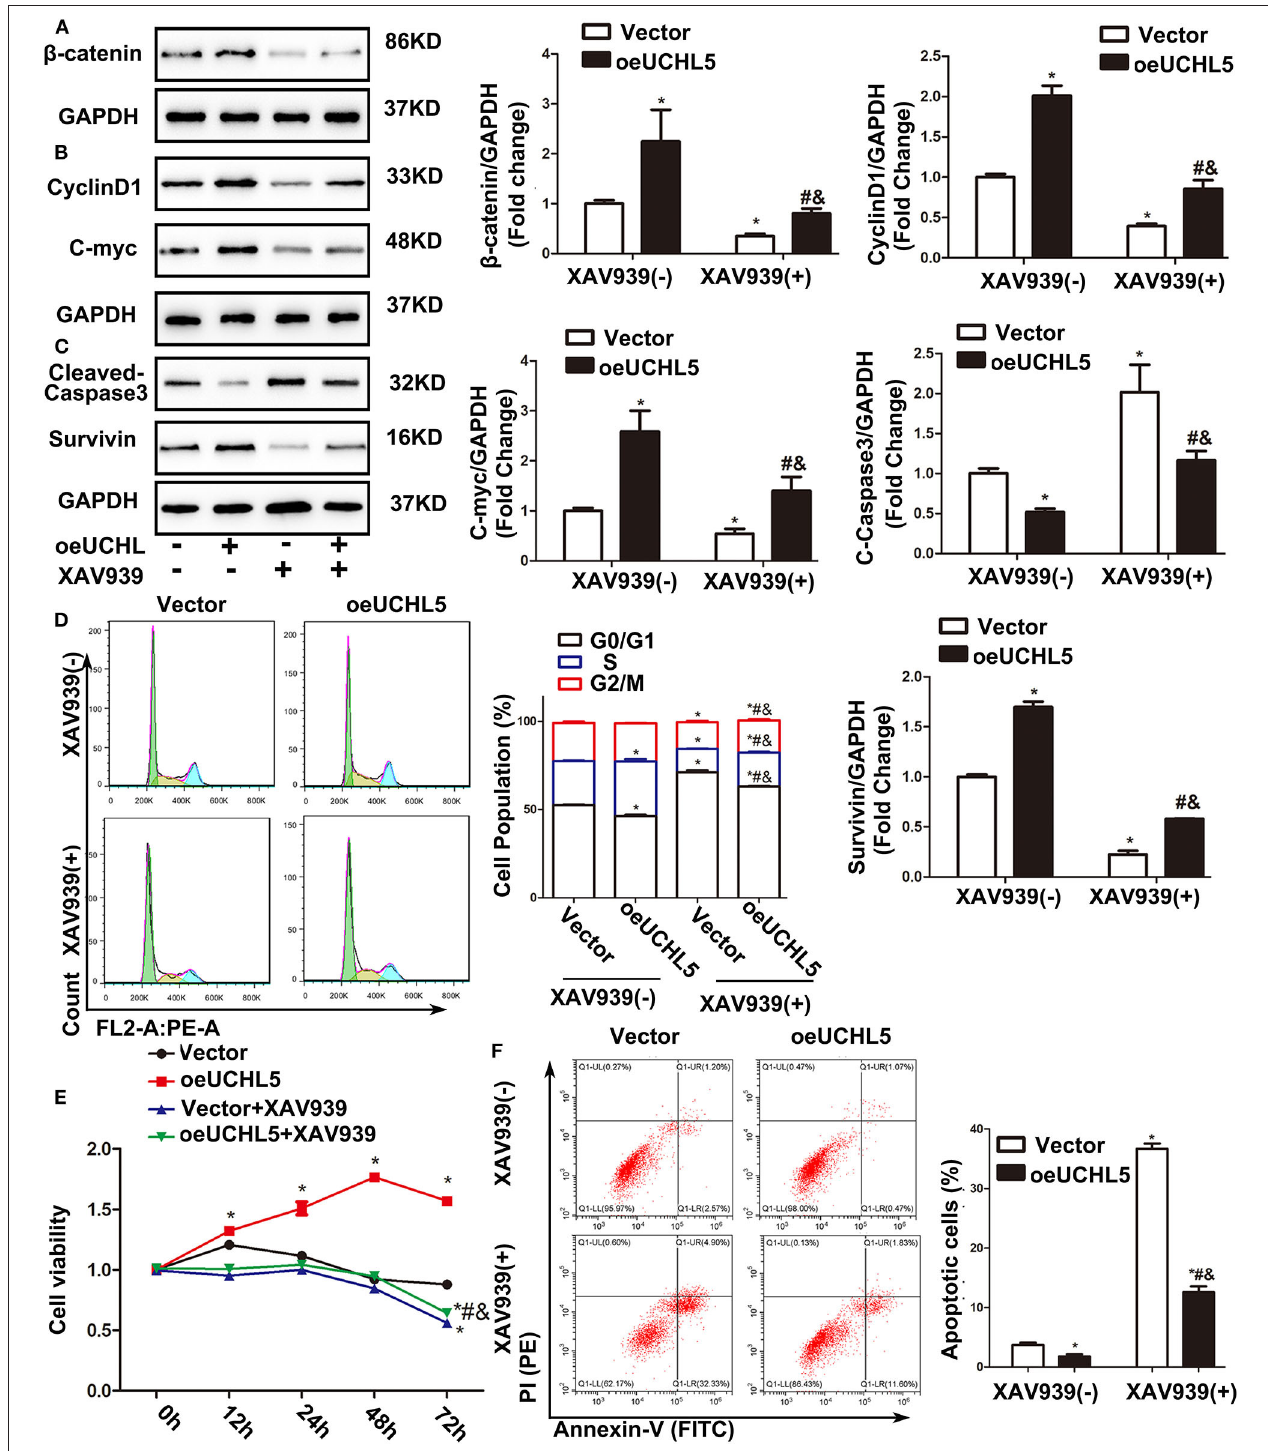
FIGURE 6 | Wnt/ β -catenin signaling pathway inhibitor XAV939 eliminated the disadvantages aroused by UCHL5 overexpression in AN3-CA cells. (A) UCHL5 overexpression (oeUCHL5). AN3-CA cells were treated with or without Wnt/ β -catenin signaling pathway inhibitor XAV939 (10 µ M) for 24h. Relative protein levels of β -catenin were detected by WB. * P < 0.05 vs. empty vector; # P < 0.05 vs. oeUCHL5; & P < 0.05 vs. vector + XAV939. (B,C) Relative protein levels of CyclinD1, C-myc, cleaved-caspase3, and Survivin were detected by WB. * P < 0.05 vs. empty vector; # P < 0.05 vs. oeUCHL5; & P < 0.05 vs. vector + XAV939. (D) Cell cycle was measured by Cell Cycle Analysis Kit ( N ≥ 3). * P < 0.05 vs. empty vector; # P < 0.05 vs. oeUCHL5; & P < 0.05 vs. vector + XAV939. (E) Relative cell viability were detected by CCK-8 at different time points ( N = 3). * P < 0.05 vs. empty vector; # P < 0.05 vs. oeUCHL5; & P < 0.05 vs. vector + XAV939. (F) The percentage of Apoptosis cells ( N ≥ 3). * P < 0.05 vs. empty vector; # P < 0.05 vs. oeUCHL5; & P < 0.05 vs. vector + XAV939.